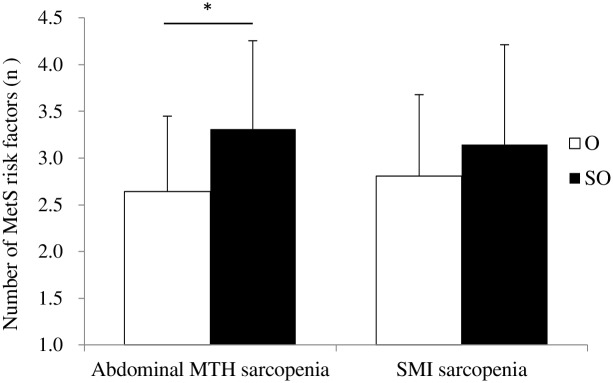
Comparison of the number of MetS risk factors between GO and SO groups, as defined by abdominal MTH and SMI.GO, General obesity; SO, Sarcopenic obesity; MetS, Metabolic syndrome; MTH, Muscle thickness; SMI, Skeletal muscle index. * P < 0.05 for significant differences relative to the GO group using ANCOVA, with adjustments for covariates of sex, age, and body mass index.